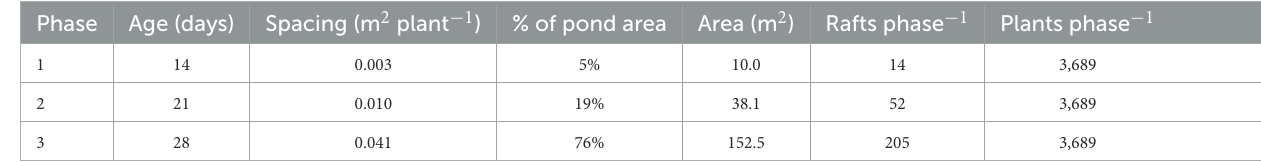
TABLE 2 Phases of hydroponic lettuce growth.